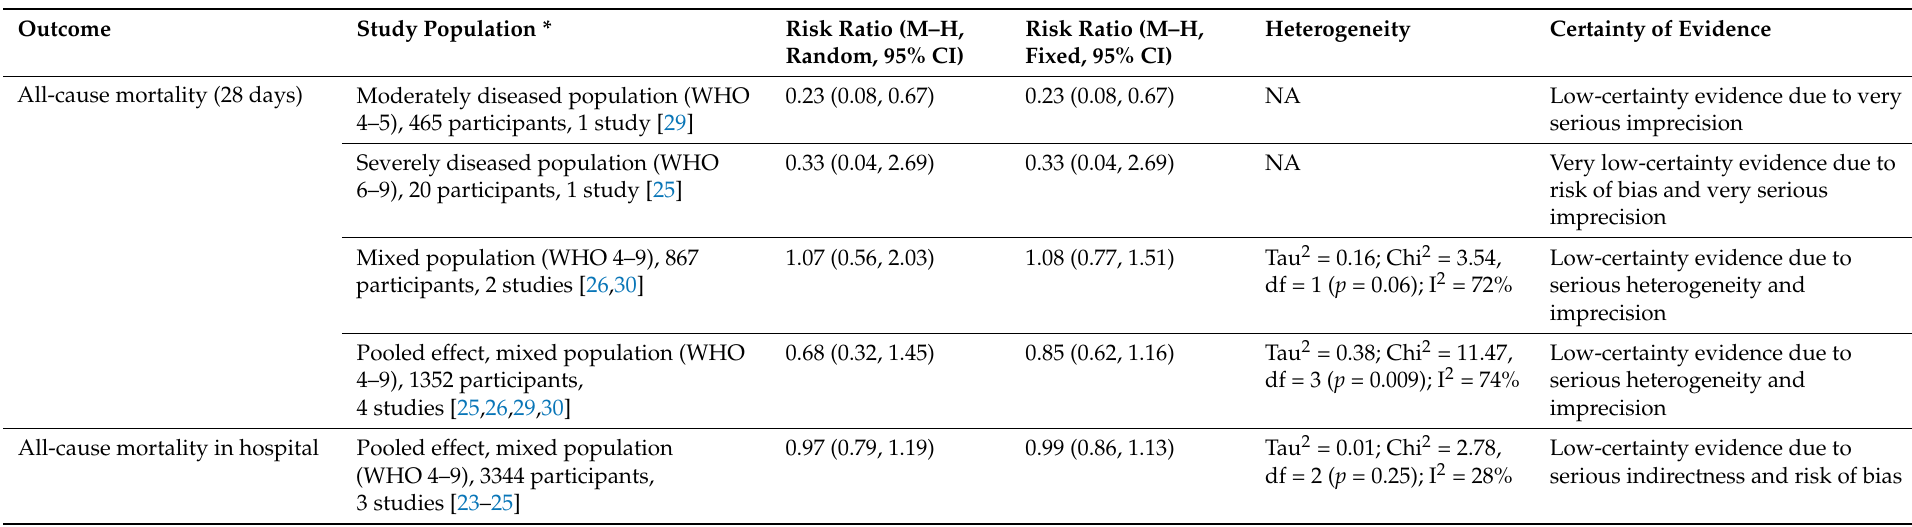
Table 3. Meta-analyses for therapeutic-dose anticoagulation according to pre-specified subgroups (moderate population and severe population) including certainty of